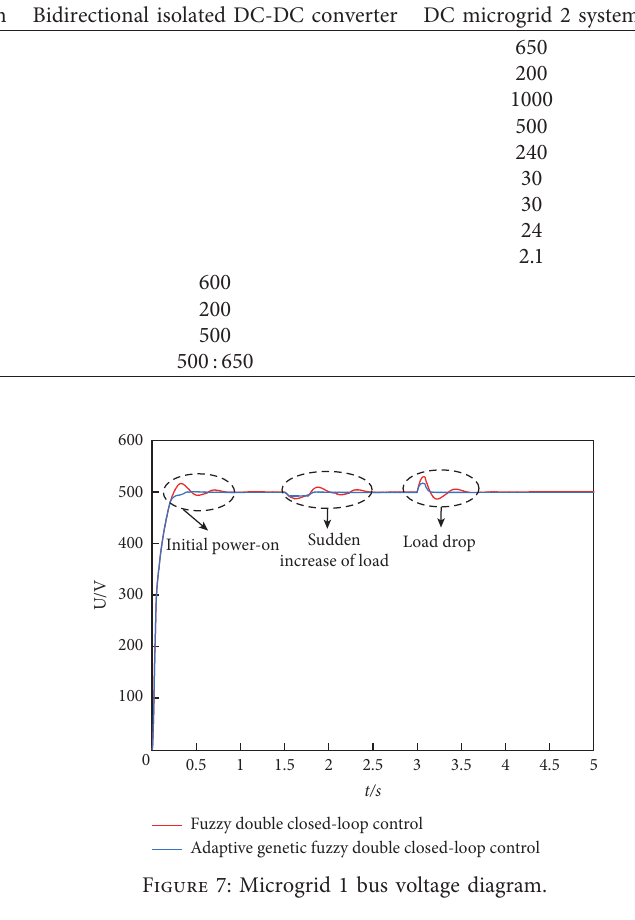
Table 3: System simulation parameters.